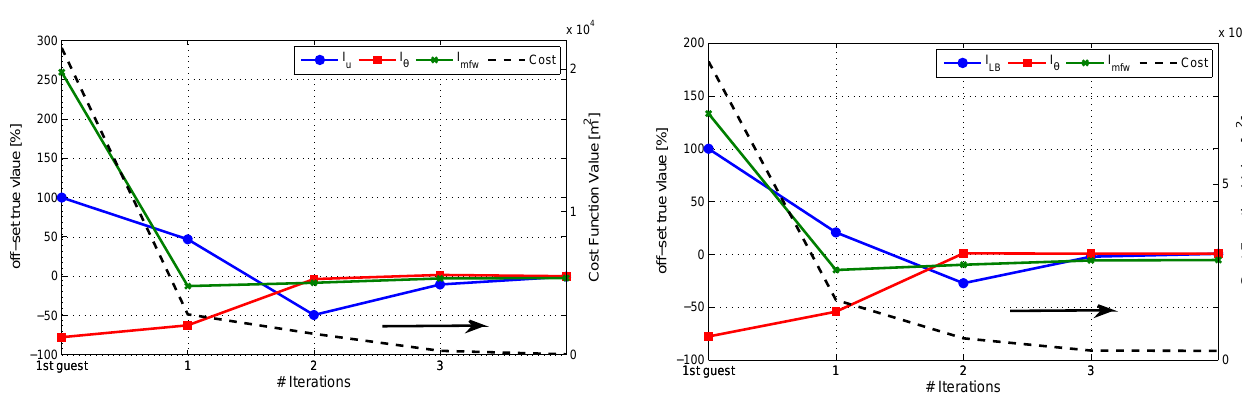
Figure 9. Cost function and invariant convergence when fuel depth is sensor data.